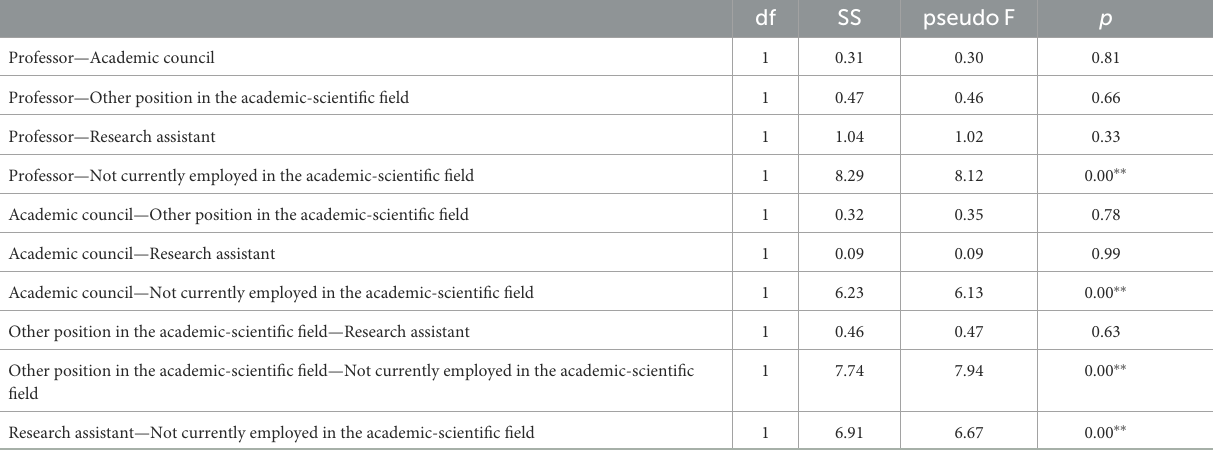
TABLE 7 Pairwise A-posteriori tests between the different employment positions.